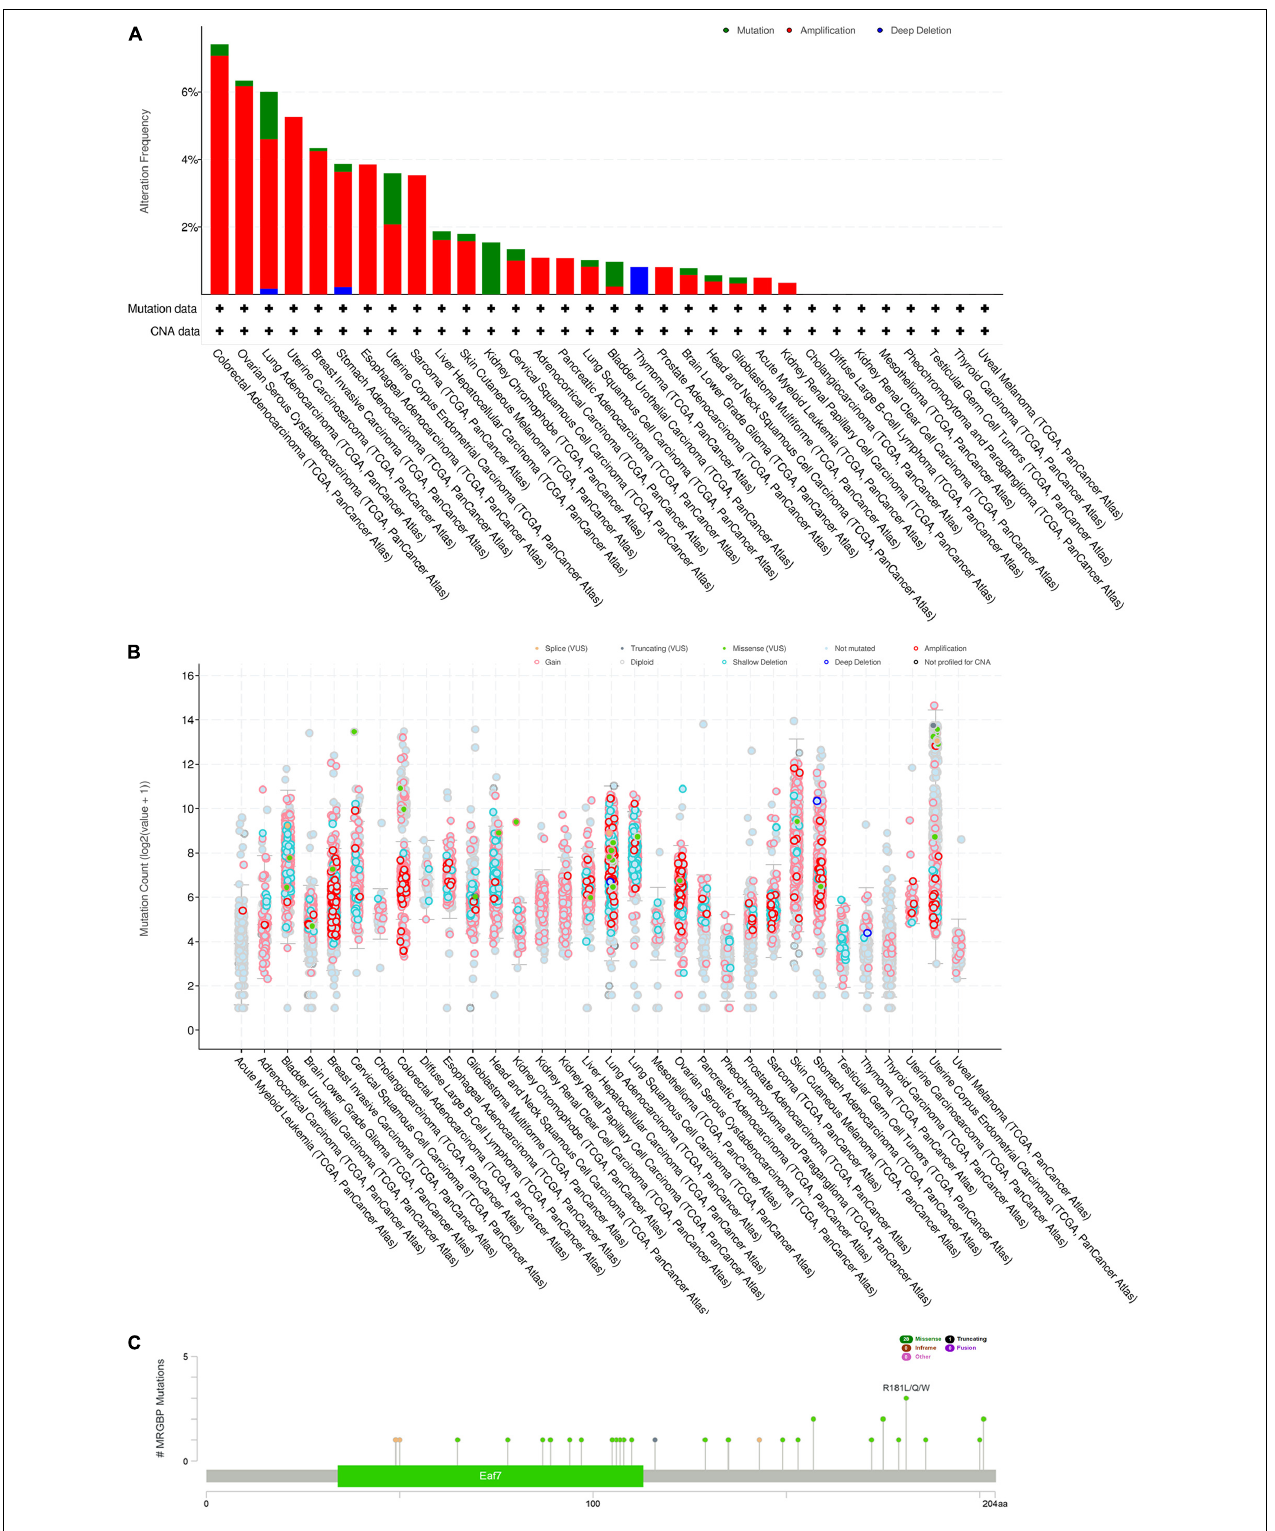
FIGURE 6 | MRGBP Copy Number Alterations and Mutations. (A) MRGBP mutation level from the cBioPortal database. (B) MRGBP mutation frequency in multiple TCGA pan-cancer studies according to the cBioPortal database. (C) Mutation diagram of MRGBP in different cancer types across protein domains from the cBioPortal